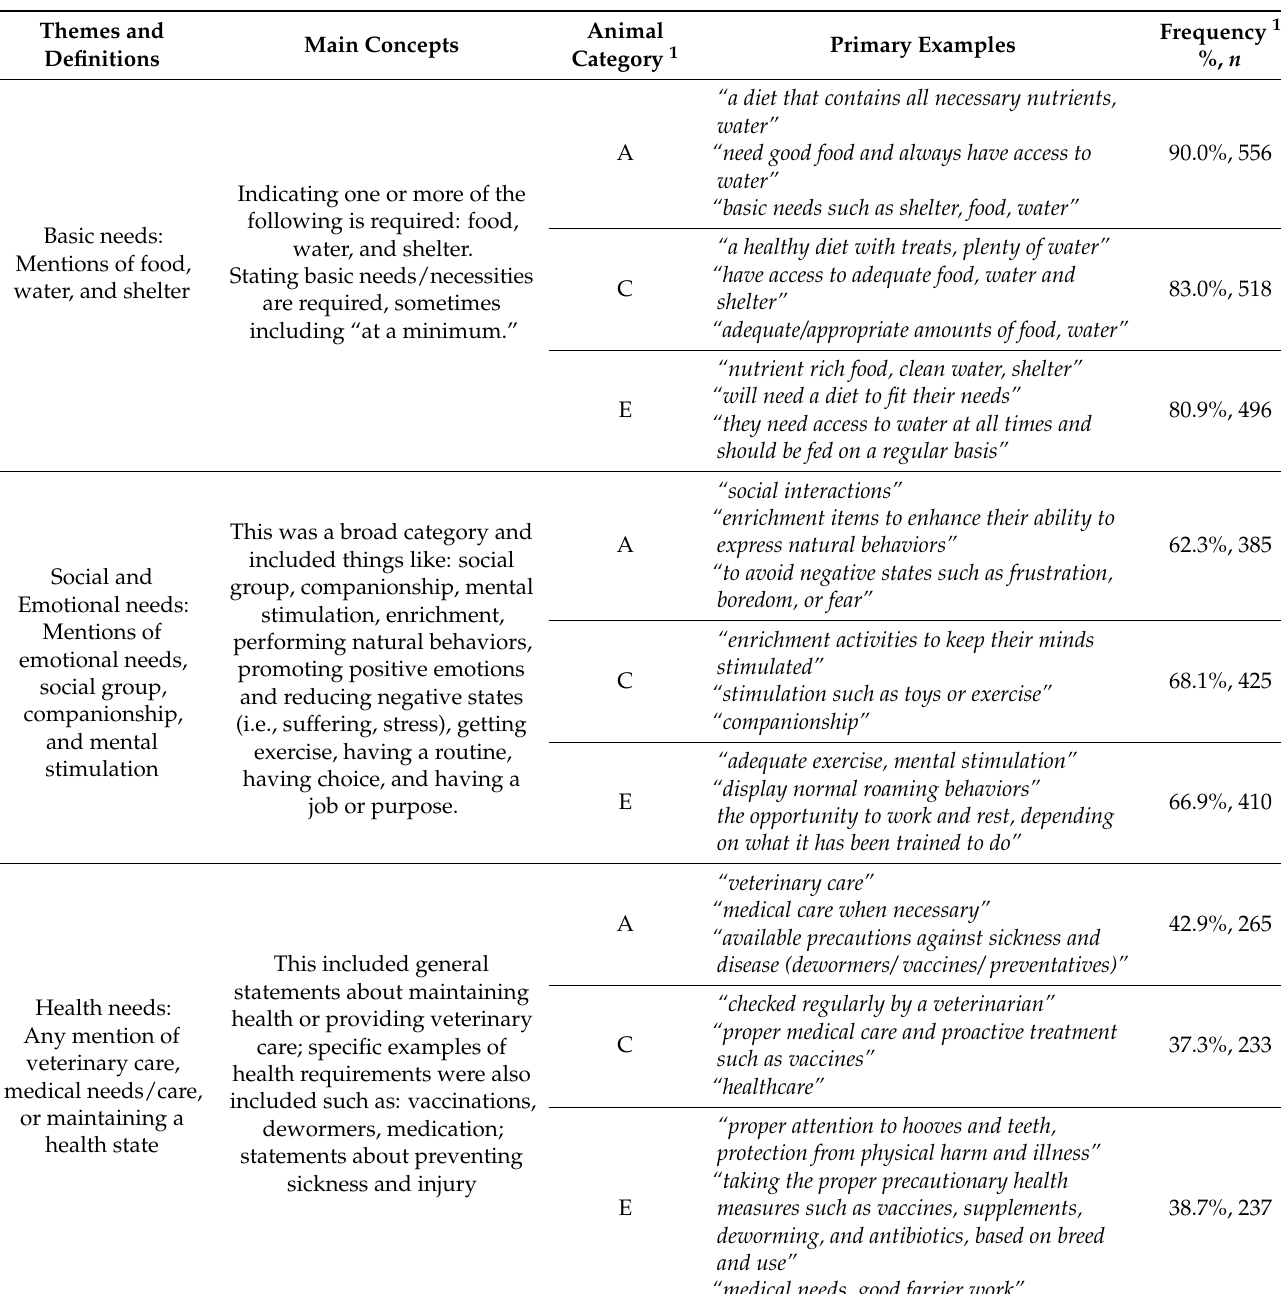
Table 5. Theme definitions, main concepts within each theme, and a sample of quotations for each theme from responses to the questions: In your opinion, what does an ((1) agricultural animal (cattle, sheep, goat, pig, or poultry intended for food and fiber use), (2) dog or cat, and (3) horse or other equid) need in order to have a good life? In the “Animal Category” column, the letter A denotes agricultural animal, C denotes dog or cat, and E denotes horse or other